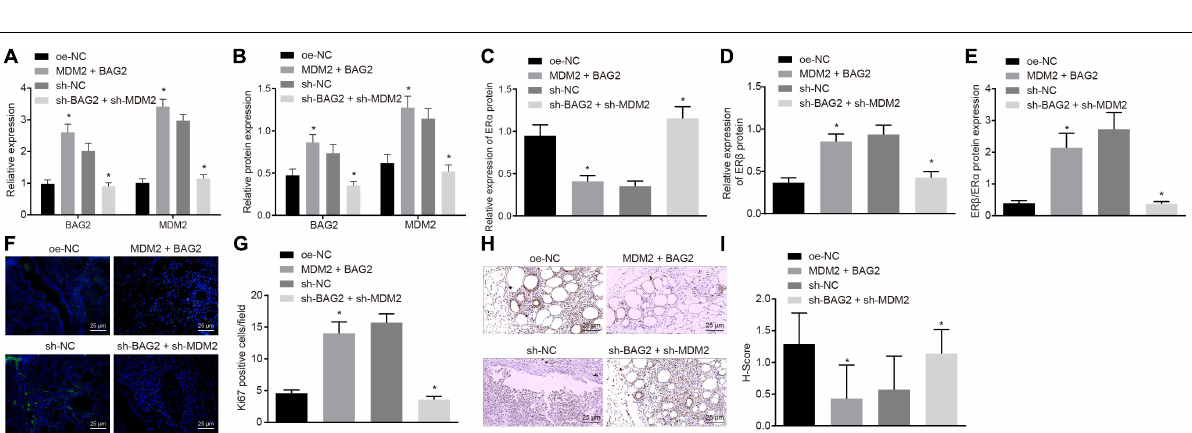
FIGURE 7 | The interference of BAG2 and MDM2 showed therapeutic effects on mouse endometriosis. Con-M mice were treated with overexpressed MDM2 and BAG2 using oe-NC as control, while En-M mice were treated using sh-BAG2 and sh-MDM2 with sh-NC as control. (A) The mRNA expression of BAG2 and MDM2 determined by RT-qPCR. (B) The protein expression of BAG2 and MDM2 determined by Western blot analysis. (C) The protein expression of ER α determined by Western blot analysis. (D) The protein expression of ER β determined by Western blot analysis. (E) The protein expression of ER β /ER α determined by Western blot analysis. (F) Fluorescence staining of Ki67 in mouse tissues. G, The statistical analysis of (F) . (H) Immunohistochemical staining of cleaved caspase 8 in mouse tissues. (I) The statistical analysis of panel (H) . Comparisons between two groups were analyzed using independent sample t -test. n = 8. * p < 0.05 vs. oe-NC treatment; # p < 0.05 vs. sh-NC